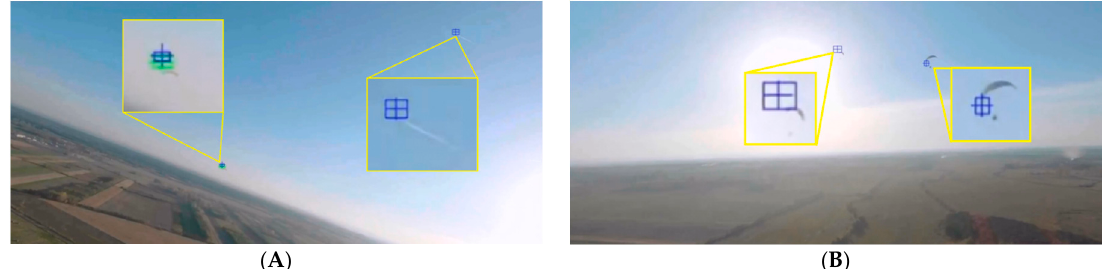
Figure 15. Situations of multiple object detection: paraglider and airliner ( A ), two paragliders ( B ).